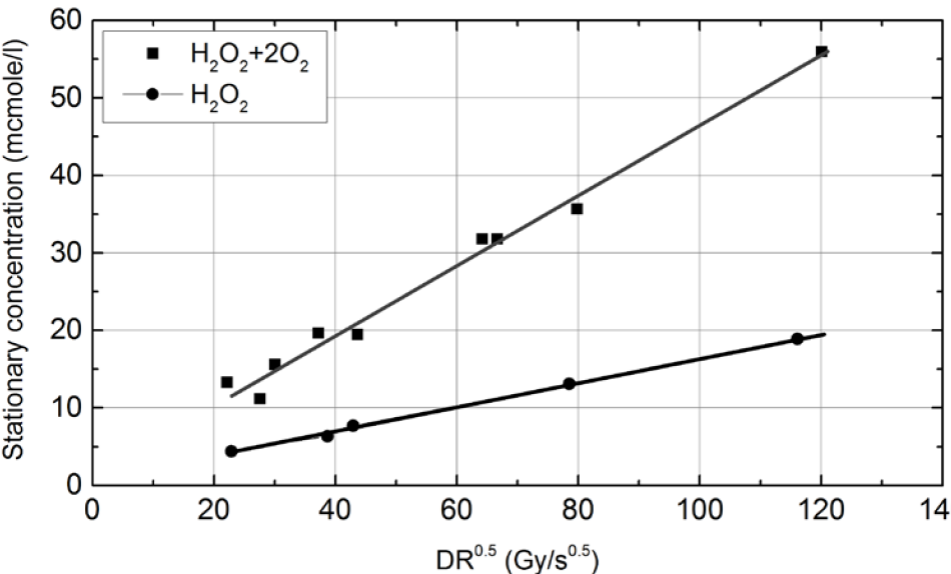
Figure 23. Dependencies of [H 2 O 2 ] + [O 2 ] and [H 2 O 2 ] on the square root of the dose rate for γ -radiolysis ( 60 Co) of water having an initial oxygen concentration of 0.5 × 10 −6 M (after Kritsky et al. [27]). © 2001 ITER Organization. This image is hereby used courtesy of the ITER Organization.